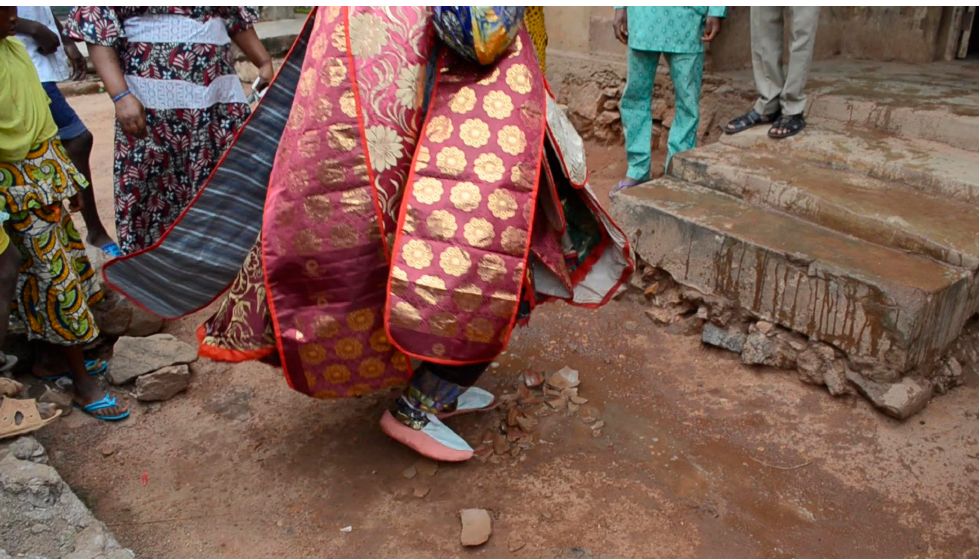
Figure 6. Egúngún Mowuru Further Breaking the Pot Placed Before It with its Feet. Source: